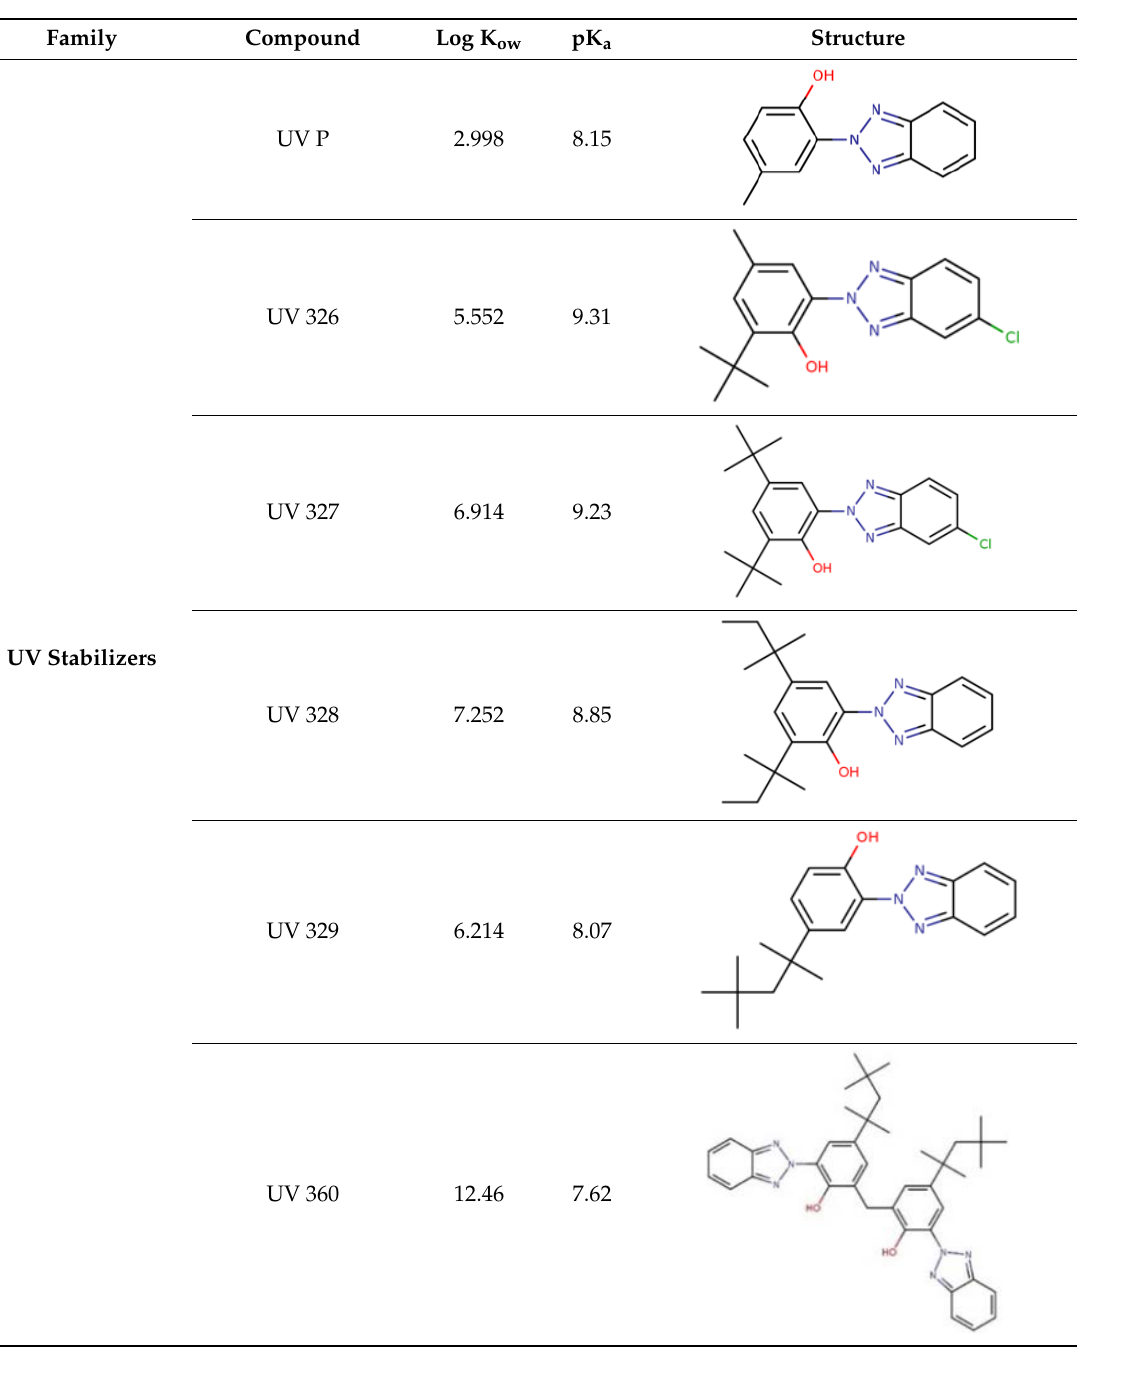
Table 1. Physicochemical characteristics of the studied compounds.